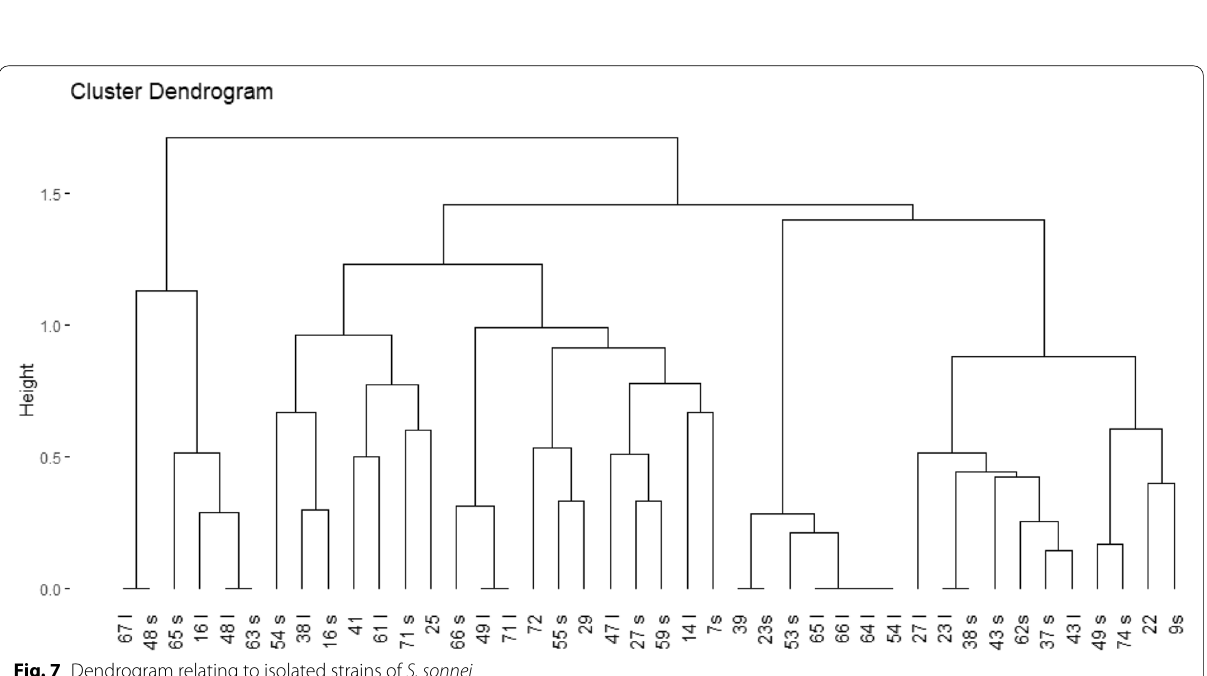
Fig. 7 Dendrogram relating to isolated strains of S.